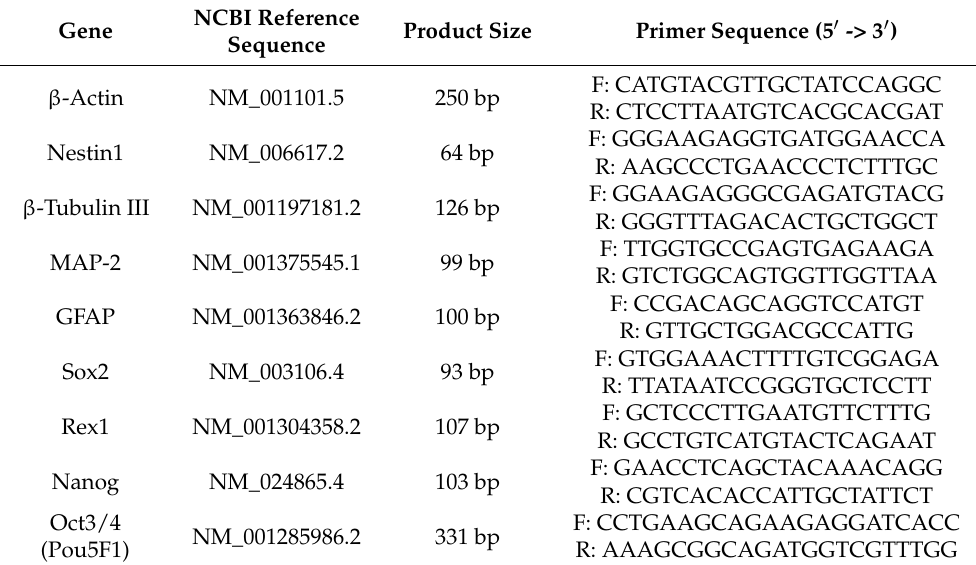
Table 3. List of primers used for Real Time-Quantitative Polymerase Chain Reaction (RT-qPCR). NCBI Reference Gene